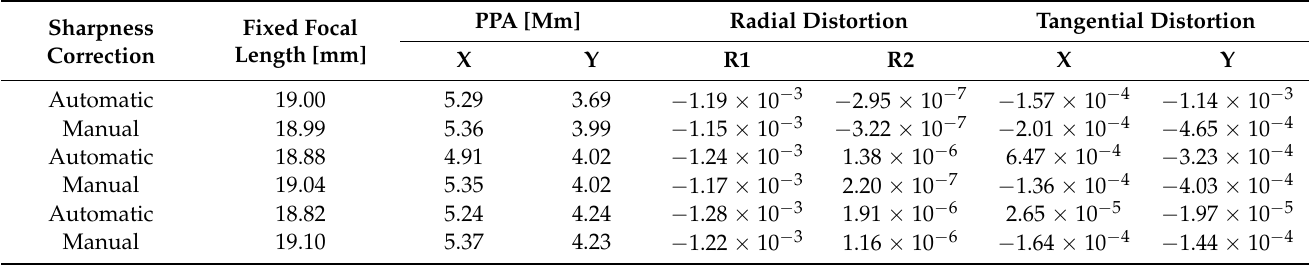
Table A1. Influence of manual and automated enhancing on geometric calibration accuracy.